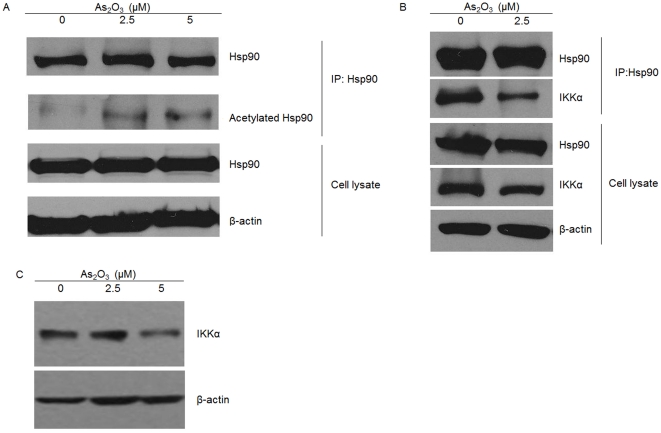
As2O3 induces hyperacetylation of Hsp90 and decreases IKKα-binding to Hsp90 by immunoprecipitation and western blot assays.(A) The accumulation of acetylated Hsp90 in NCI-H929 cells were cultured with As2O3 (0 µM, 2.5 µM, and 5 µM) for 48 hours. (B) Hsp90-IKK interaction in NCI-H929 cells were cultured with As2O3 (2.5 µM) for 48 hours. (C) The IKKα protein expression in myeloma cells treated with As2O3 (0 µM, 2.5 µM, and 5 µM) for 48 hours.